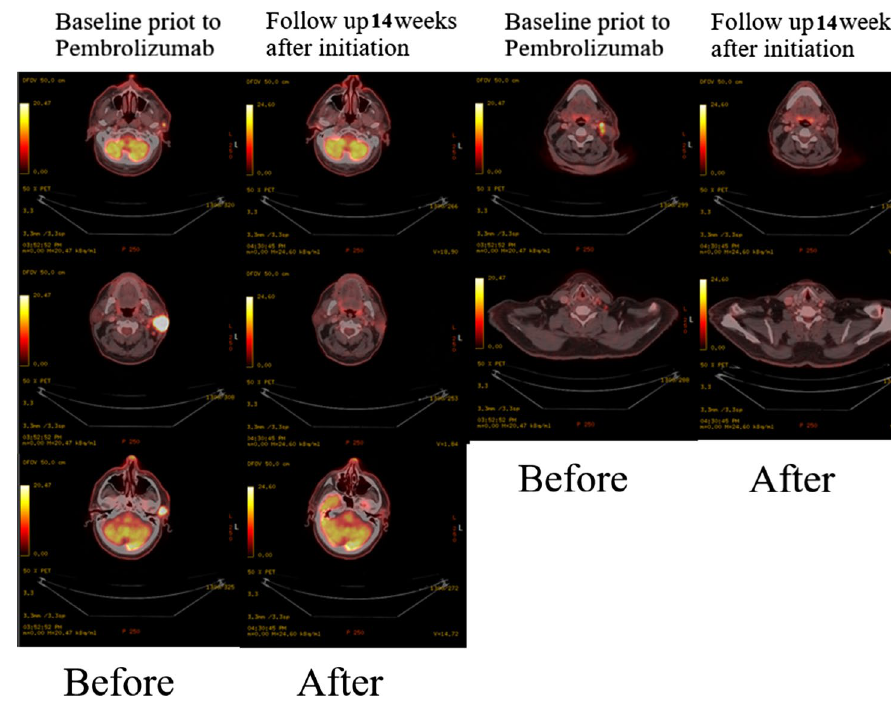
Fig. 9 PET CT before and after treatment. Left side column—baseline prior to Pembrolizumab. Right side column—follow up 14 weeks after